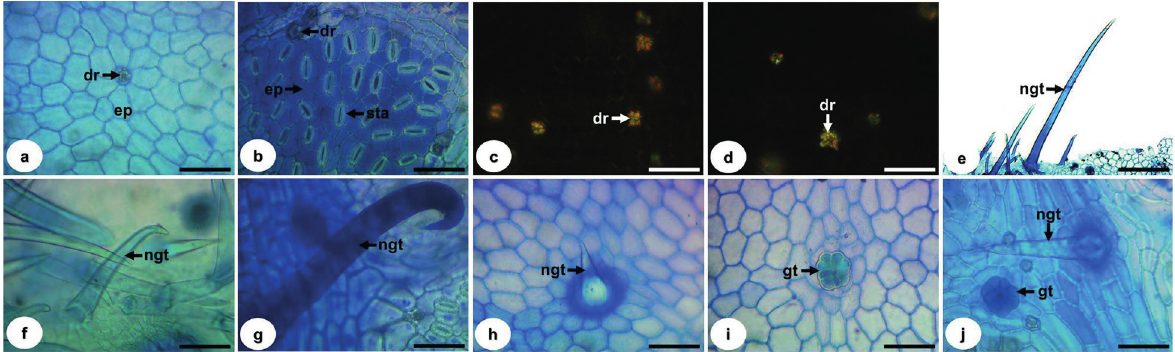
Figure 1 - Paradermal sections of the leaf blade of Artocarpus altilis . a , b , e , f , g , h , i and j : optical microscopy; c and d : polarized light microscopy; a , c , e , f , h and i : adaxial face; b , d , g and j : abaxial face. Abbreviations: dr = druse; ep = epidermis; gt = glandular trichome; ngt = non-glandular trichome; sta = stomata. Bars: a , b , e , f , g , h , i and j = 50 µm; c and d = 20 µm.